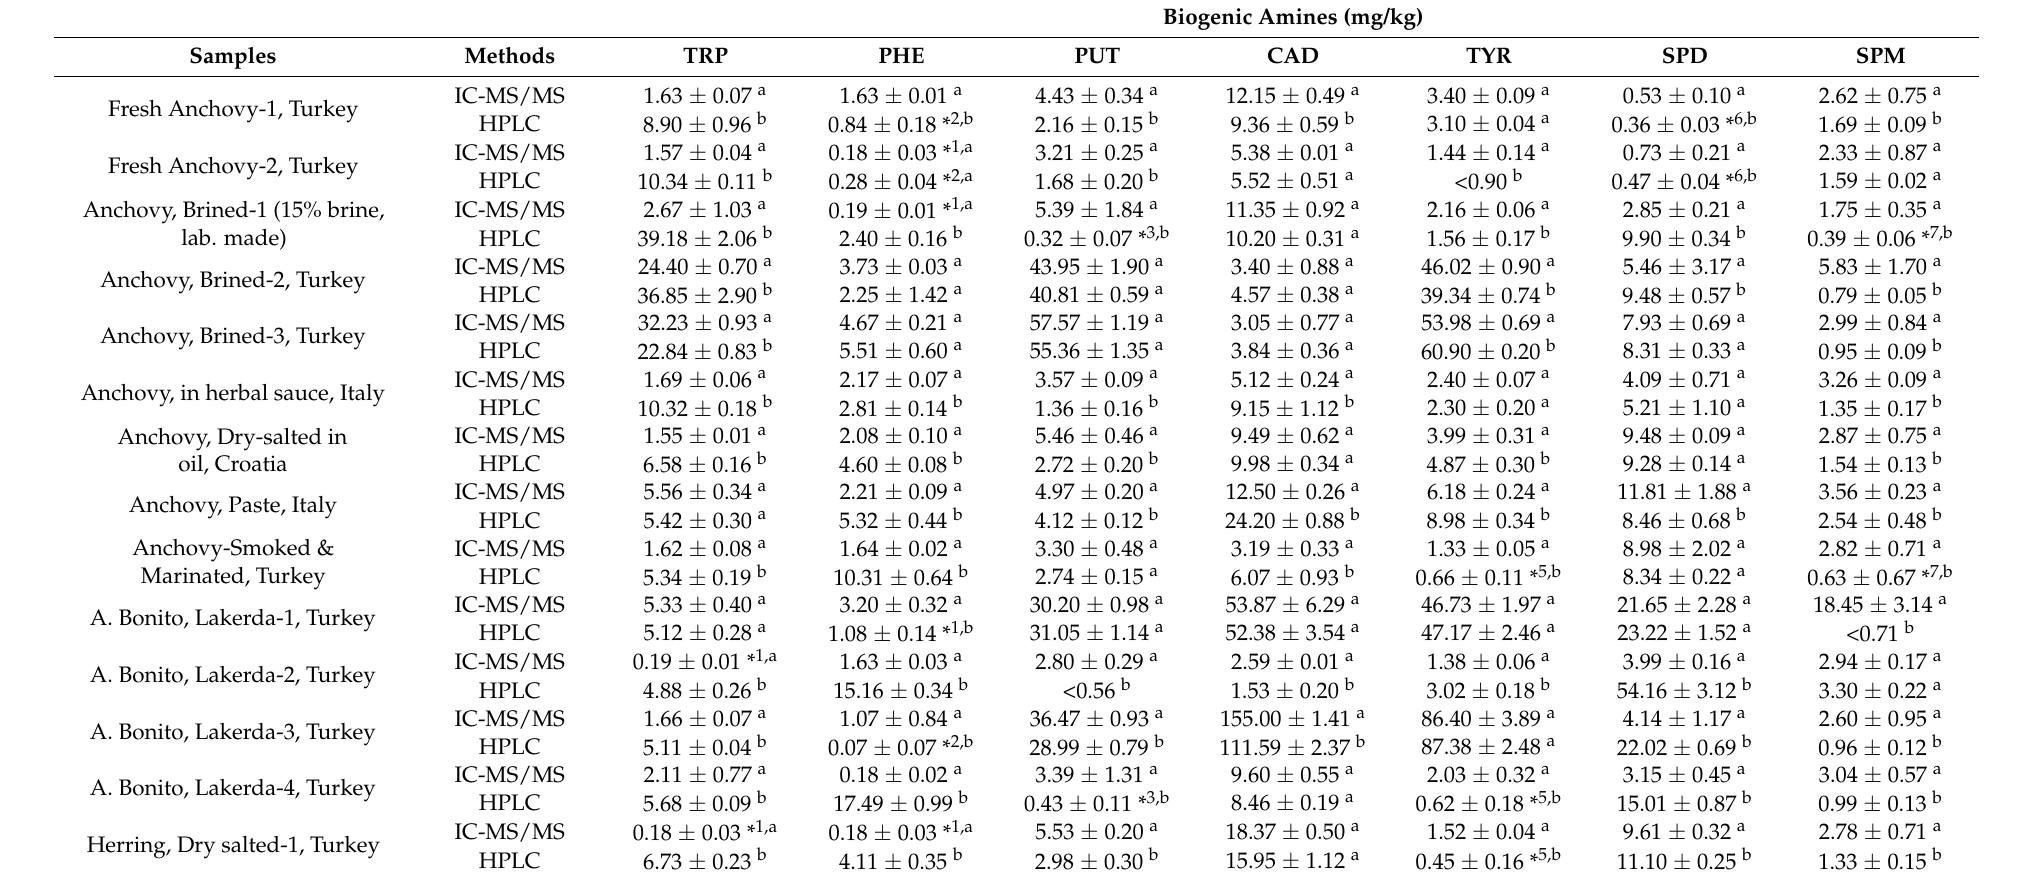
Table 2. Comparison of the IC-MS/MS and HPLC methods for analyzing 7 biogenic amines in fish